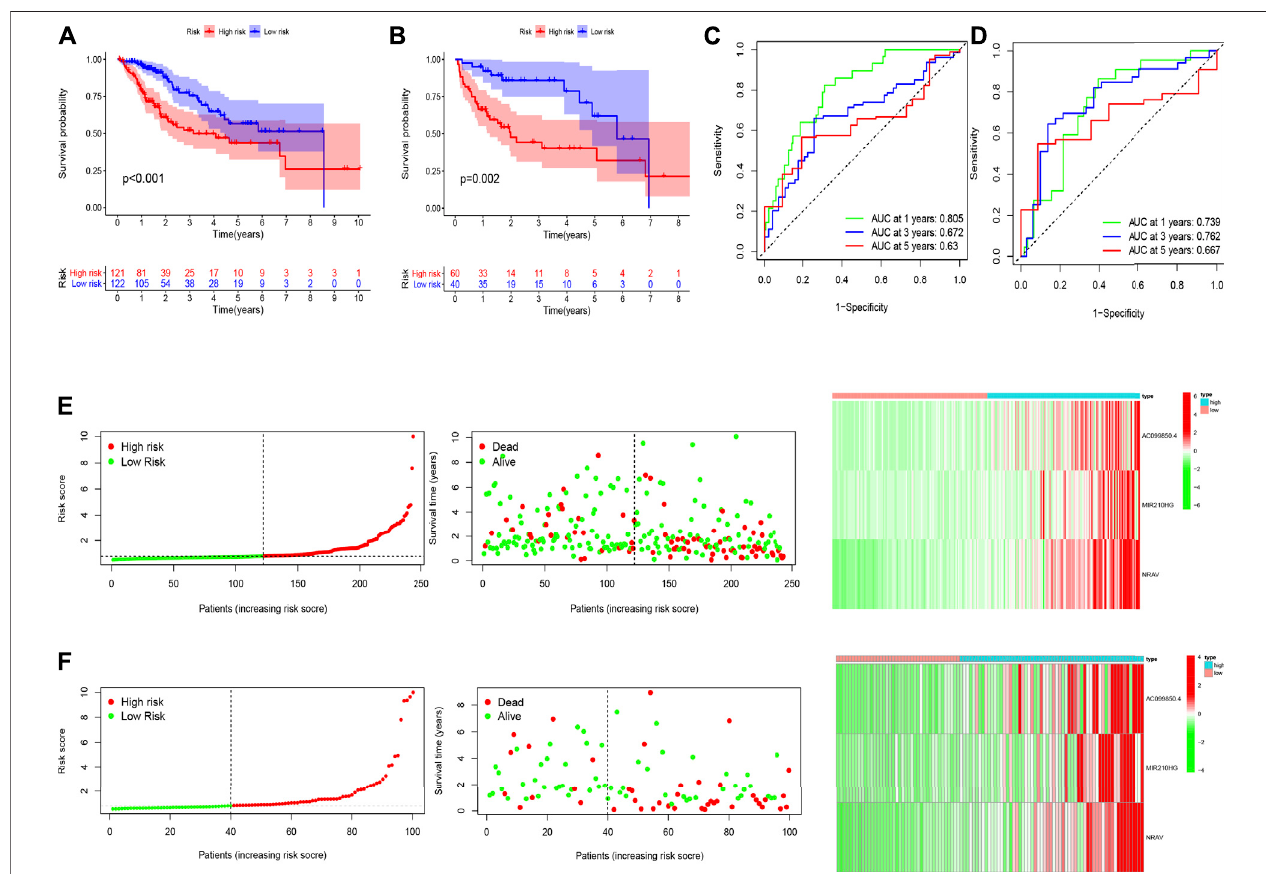
FIGURE 3 | The results of Kaplan-Meier analysis, ROC curves, and risk survival status plots in train (A,C,E) and test (B,D,F) sets.